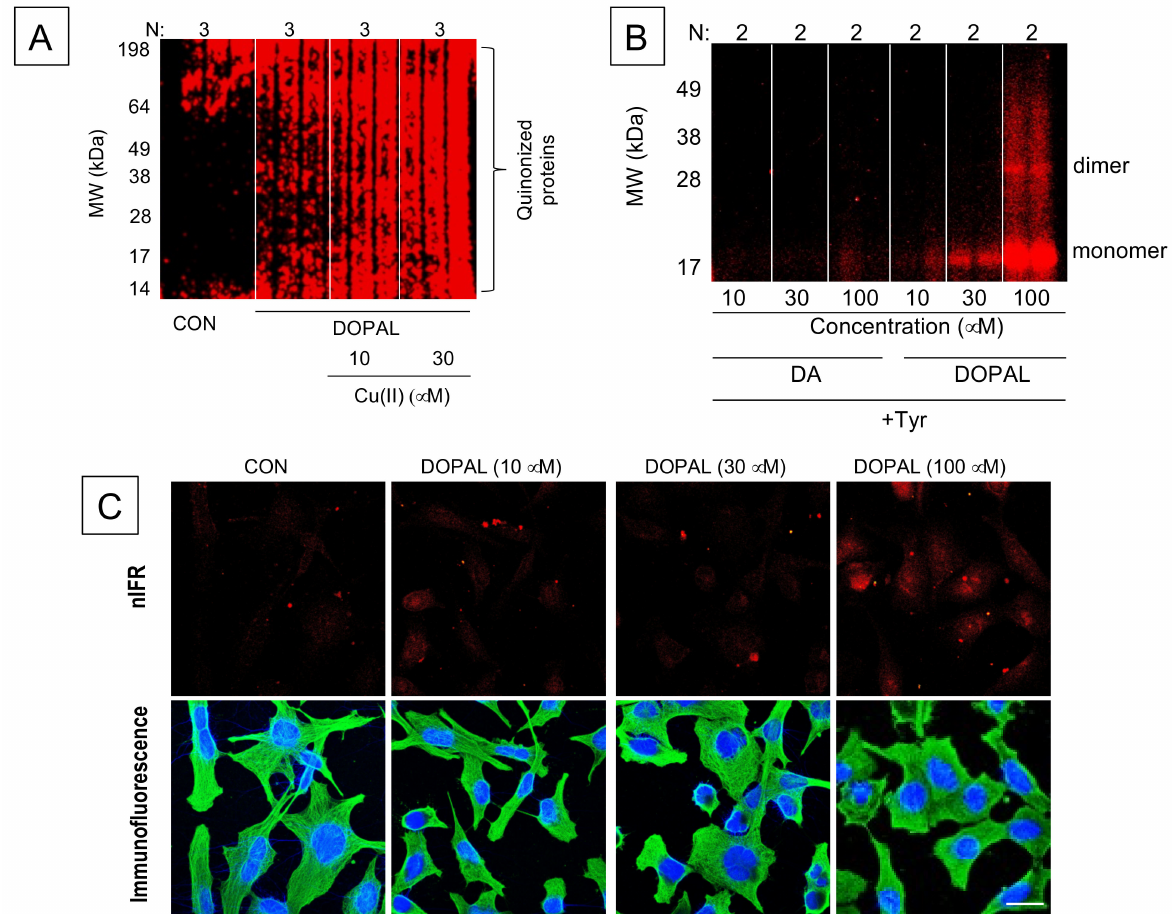
Figure 5. Intracellular quinoproteins produced by 3,4-dihydroxyphenylacetaldehyde (DOPAL) . ( A ): DOPAL-induced quinonization of intracellular proteins in MO3.13 human cultured oligodendrocytes. MO3.13 cells (1.5 × 10 5 cells/well) were exposed to ( A ) DOPAL (100 µ M) with or without Cu(II) (10 and 30 µ M) for 24 h. DOPAL-quinonized proteins were detected and quantified by infrared fluorescence (nIRF) spectroscopy (red). N = number of replicates. DOPAL quinonized myriad intracellular proteins. Cu(II) augmented this effect. ( B ): Comparisons of dopamine (DA)- vs. DOPAL-induced alpha- synuclein ( α S) quinonization. Quinonized α S was detected by near infrared fluorescence (nIRF) spectroscopy (red). Even in the presence of tyrosinase (Tyr) to oxidize DA, DA did not quinonize α S. ( C ): Visualization of intracellular DOPAL-induced quinoproteins. MO3.13 cells were cultured in slide chambers (8 × 10 4 cells/slides) for 24 h and treated with Cu(II) (30 µ M) and 0–100 µ M DOPAL for 5 h. Cells were then stained with DAPI (1:2000) (blue) and human tubulin antibody (1:1500) (green). Immunofluorescence and near infrared fluorescence (nIRF) were visualized microscopically. Scale bar in images is 20 µ M. Treatment with DOPAL produced nIRF signals, indicating the presence of quinoproteins. Images are from